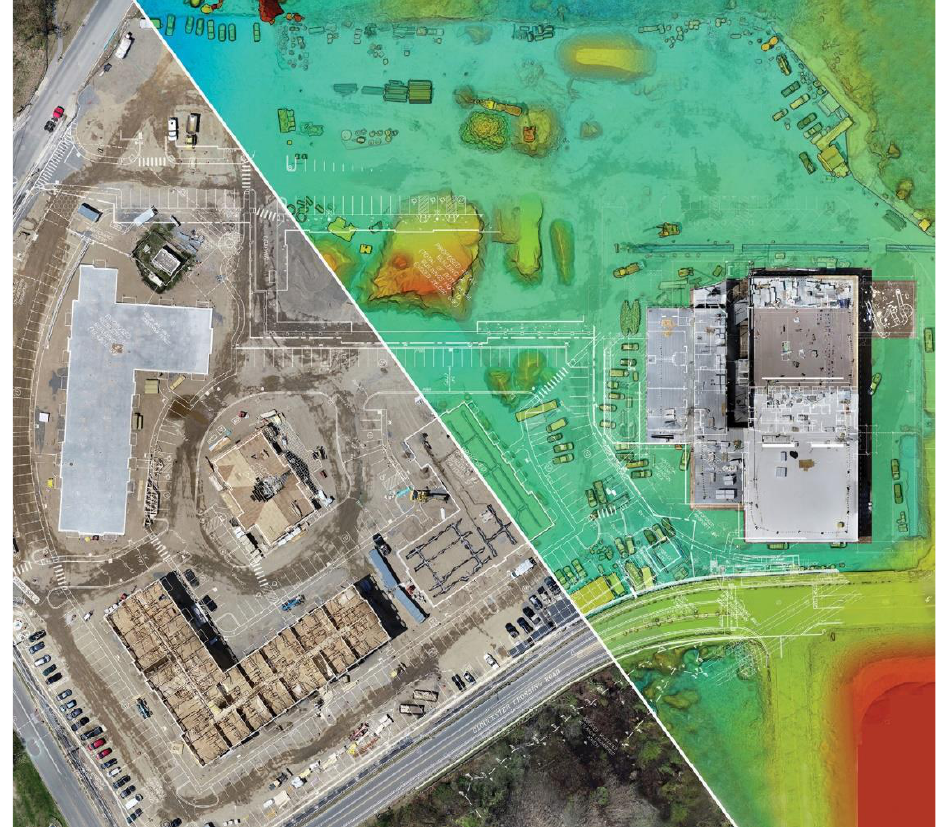
Figure 1: Drone mapping overlay with a design plan and as-built on-site progress